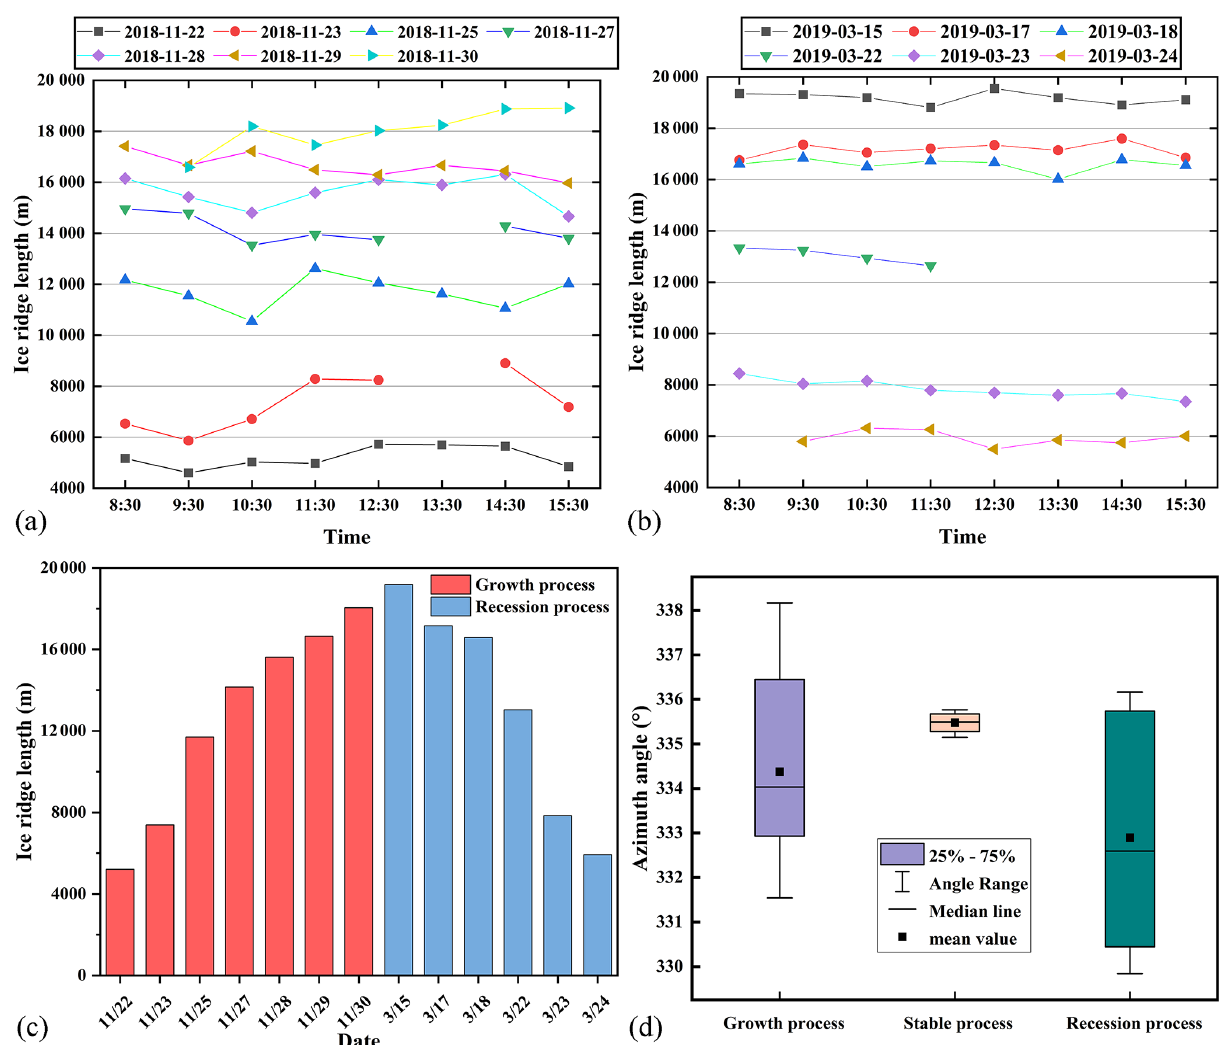
Figure 6. The changes in the ice ridges during the cold season of 2018–2019. (a) Length changes during the growth process from 22 to 30 November 2018, as measured from 53 ESTARFM fusion images. (b) Length changes during the recession process from 15 to 24 March 2019, as measured from 43 ESTARFM fusion images. (c) The daily average length. (d) The angles of ice ridges in different